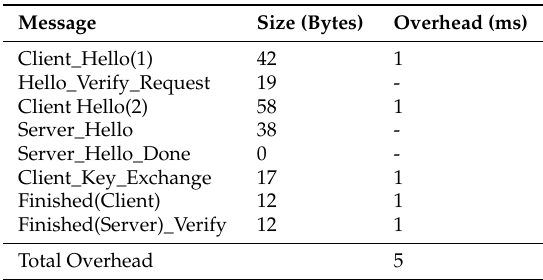
Table 5. DTLS-PSK packet size and